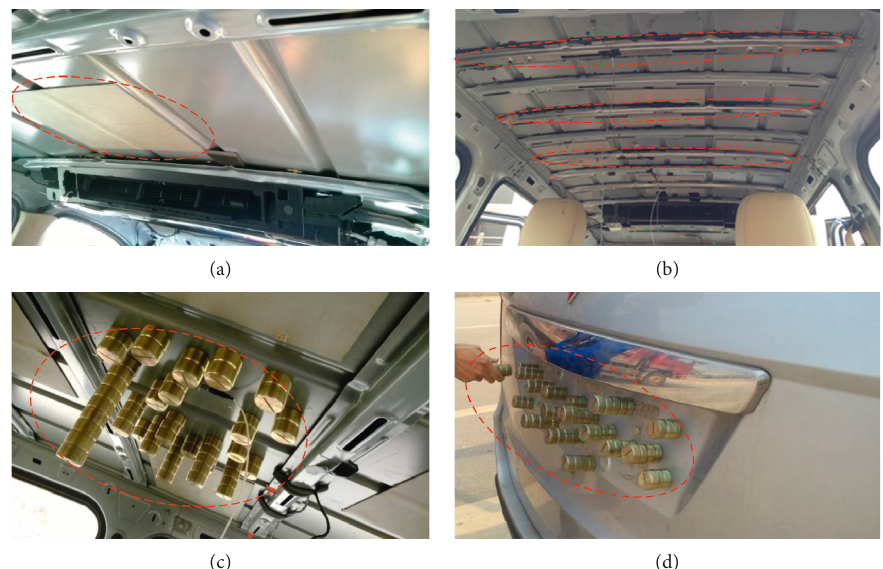
Figure 33: Vehicle body modifications. (a) Damping on the ceiling. (b) Increasing the number of beams. (c) Mass on the ceiling. (d) Mass on the back